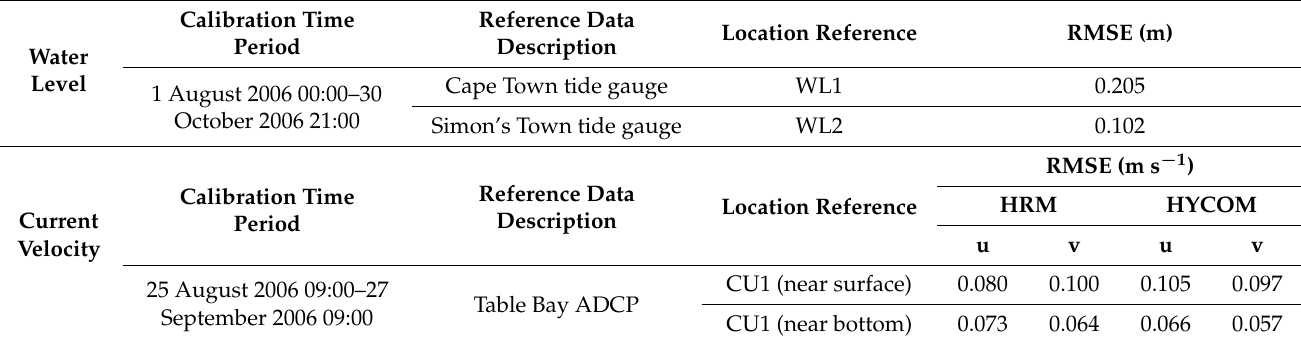
Table A2. Summary of water level and current performance statistics after the iterative calibration of the HRM, using the final parameterisation settings (see Table